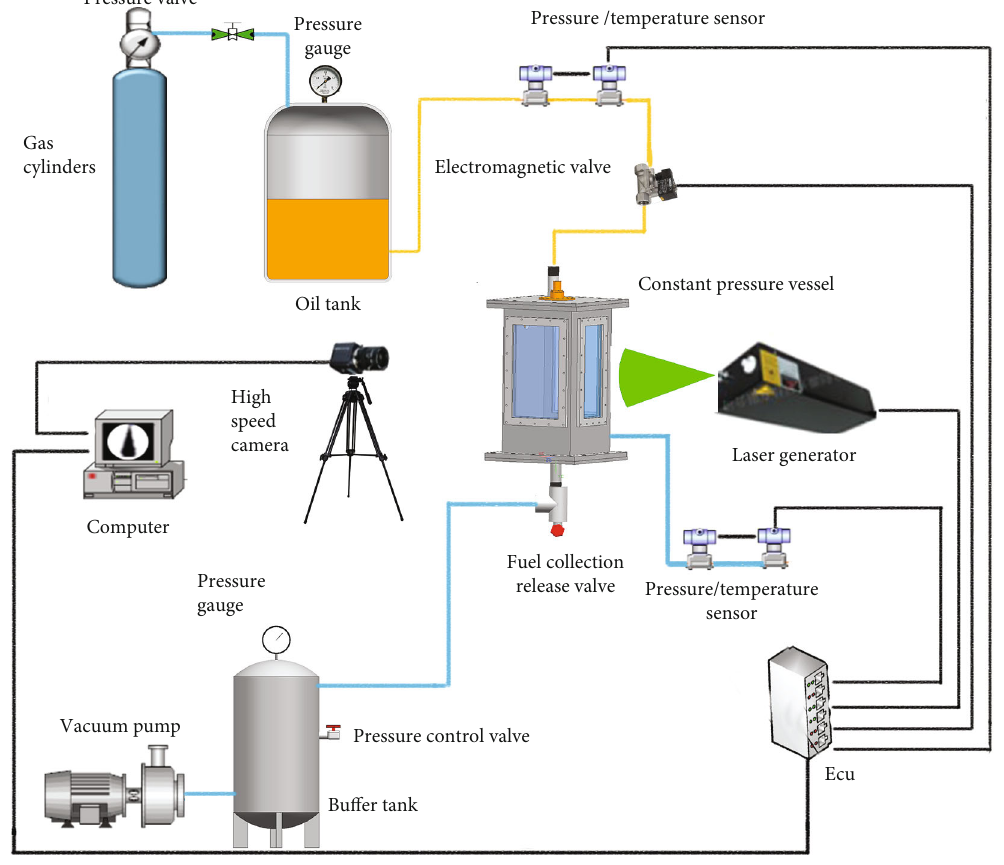
Figure 1: Schematic of the experimental facility. Table 1: Properties of fuel